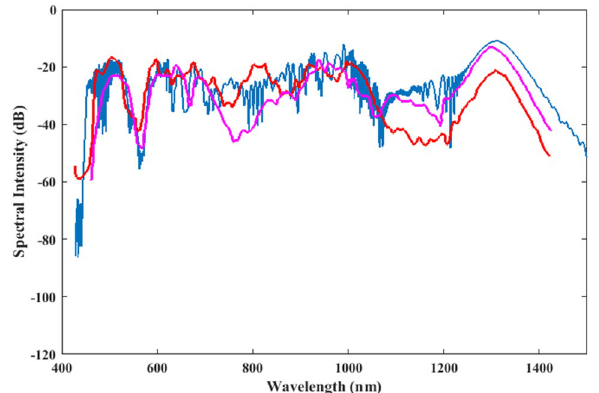
Figure 3. A comparison between the present simulation of supercontinuum generation (the blue line), the experimental results (the red line) and the simulation results (the purple line) of Corwin et al. 43